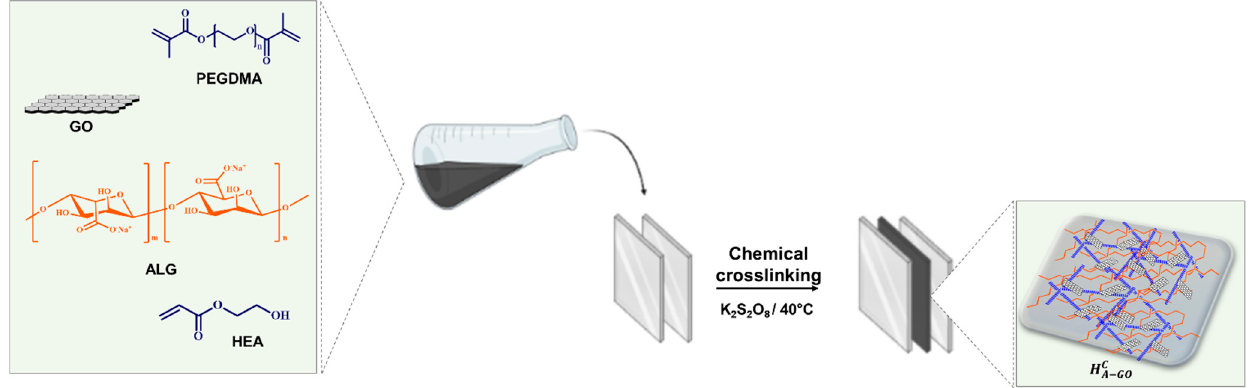
Figure 2. Schematic representation of the preparation of 𝐻 (cid:3002)(cid:2879)(cid:3008)(cid:3016)(cid:3004) hydrogels.